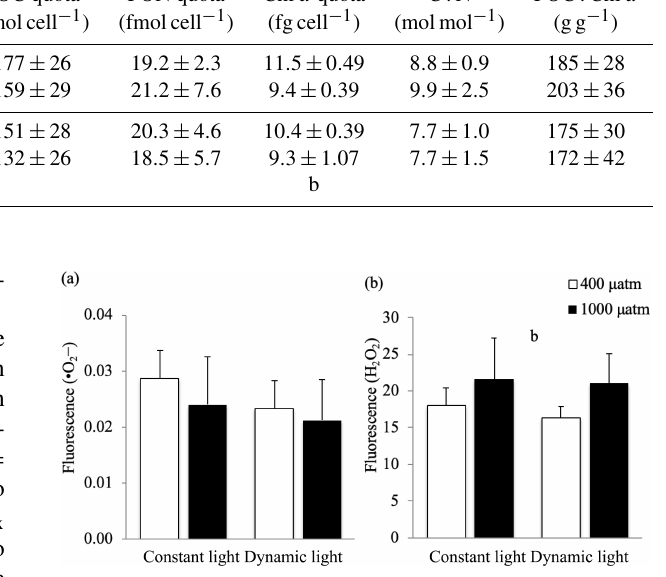
Table 2. Growth and cellular composition of M. pusilla ( n = 4; mean ± 1 SD), including the growth rate, POC production, POC quota, PON quota, chlorophyll a quota, C:N ratio and POC:chlorophyll a ratio. Treatments include constant light and dynamic light and the two p CO 2 levels of 400 and 1000µatm. The letters indicate significant differences between treatments ( p < 0 . 05) represented as (a) light and (b) p CO 2 . Light p CO 2